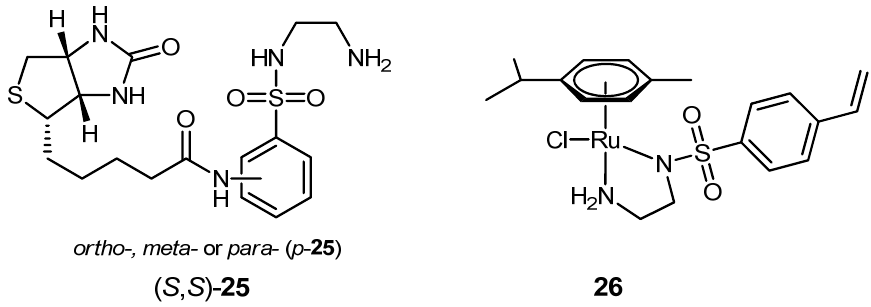
Figure 7. Ligands and complexes in biomimetic